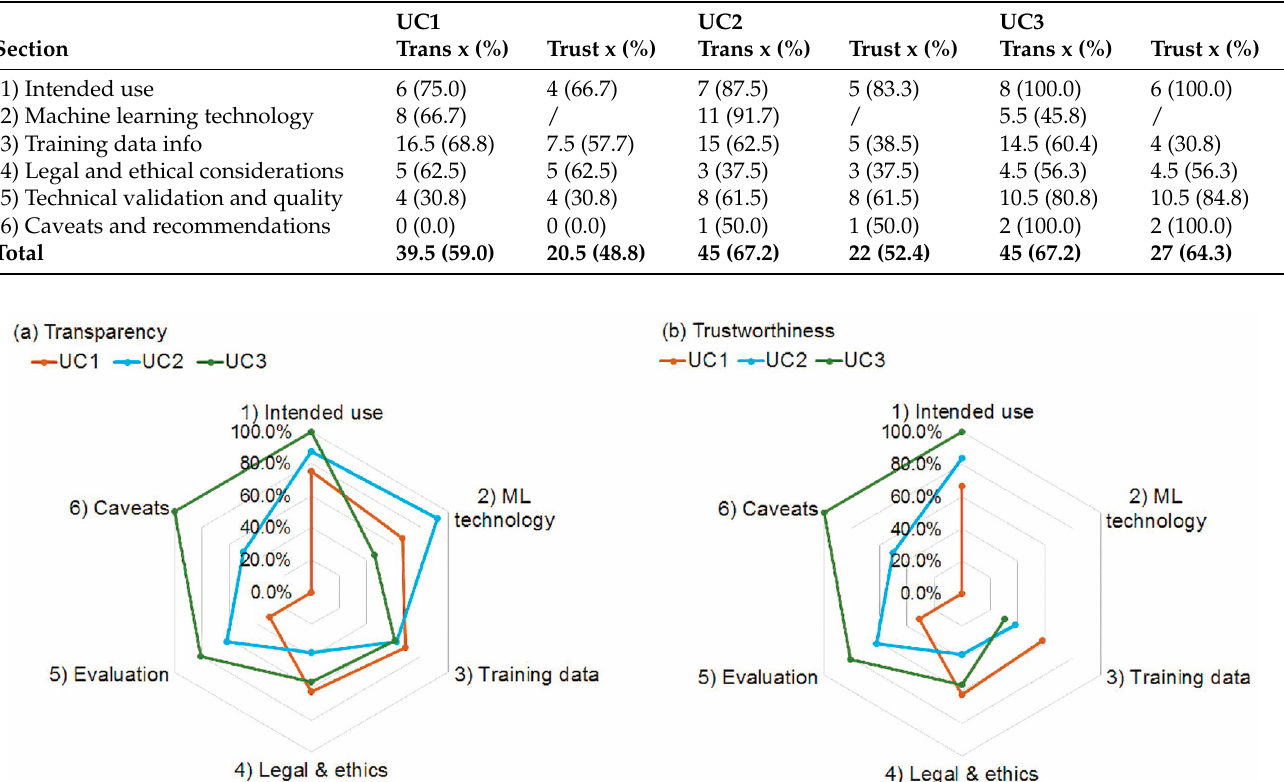
Table 2. Transparency (Trans) and trustworthiness (Trust) scores among all three use cases. Scores are displayed for each section in the questionnaire and among all questions that were selected for the assessment. Transparency and trustworthiness scores are listed as absolute values (x) and percentages relative to the maximum score for each section (%).